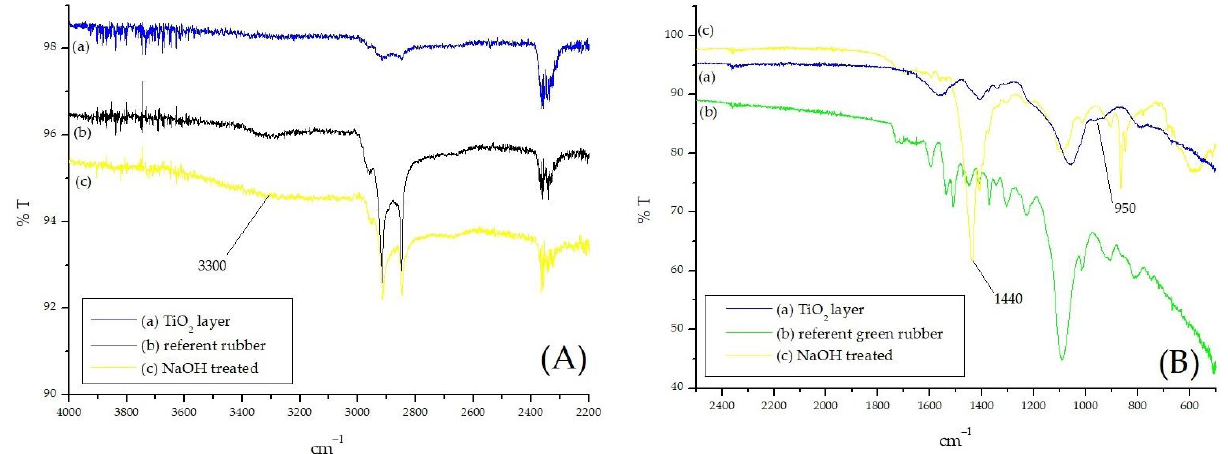
Figure 14. ( A ) FTIR spectra in the range of 4000 – 2200 cm −1 of ( a ) immobilized TiO 2 on referent black rubber, ( b ) referent black rubber, and ( c ) etched black rubber with NaOH solution; ( B ) FTIR spectra in the range of 2500 – 500 cm −1 of ( a ) immobilized TiO 2 on referent green rubber, ( b ) referent green rubber, and ( c ) etched green rubber with NaOH solution.